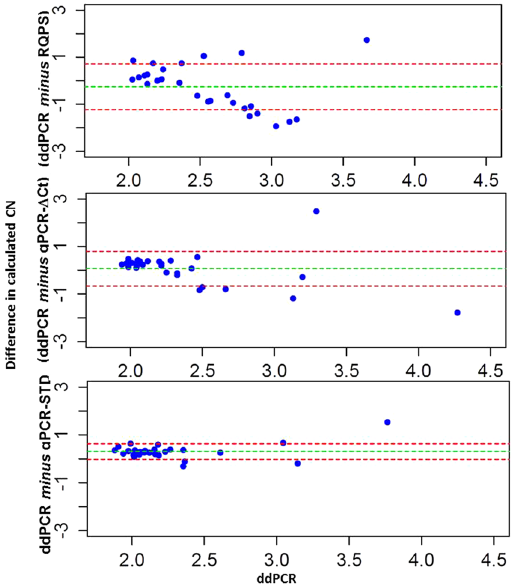
Figure 4. Bland-Altman plot showing the difference between the predicted CN of qPCR methods and RQPS against the ddPCR CN prediction. Each blue dot represents the CN difference for one individual. The dashed green line shows the mean difference, while the dashed red lines show 95% confidence